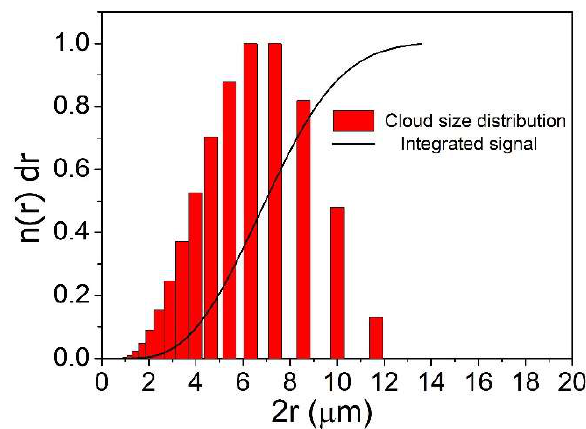
Figure 8. A typical droplet size distribution measured by the SprayTech during the experiment.